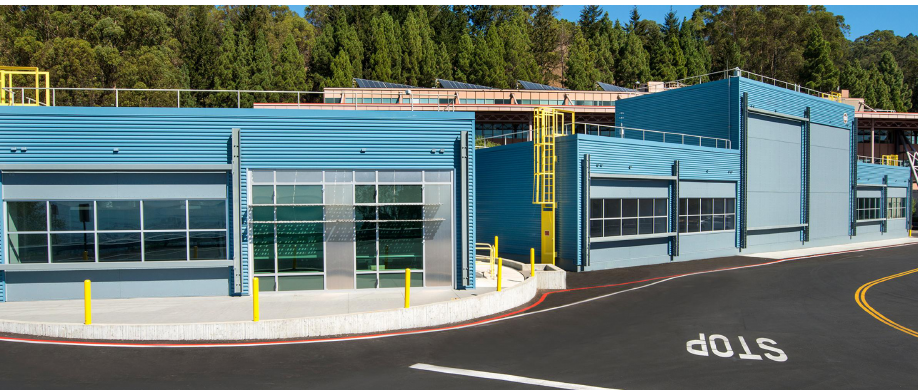
Figure 4. FLEXLAB facility where the target data set research was